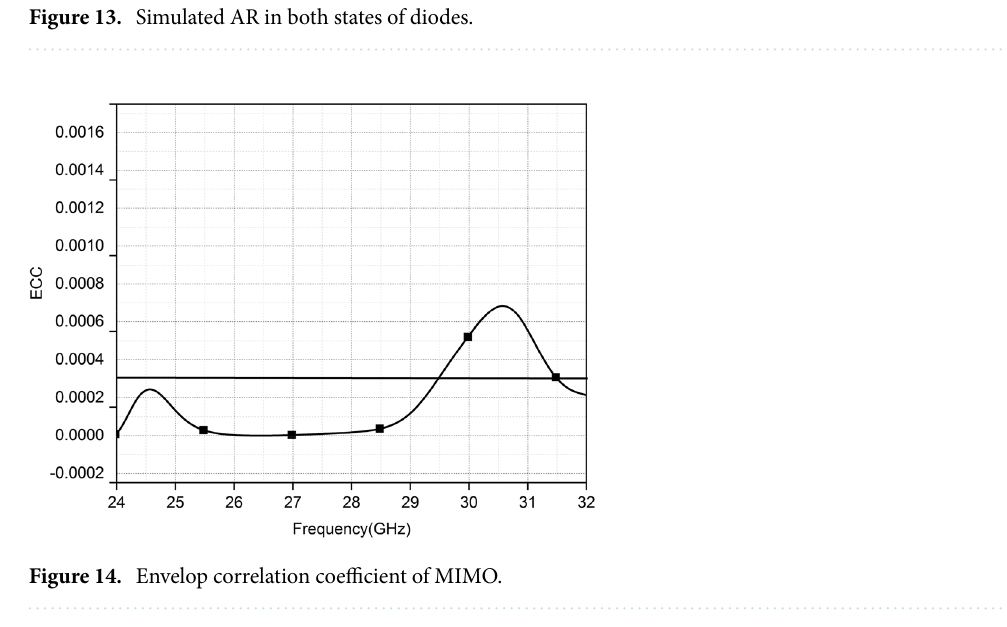
Figure 13. Simulated AR in both states of diodes.